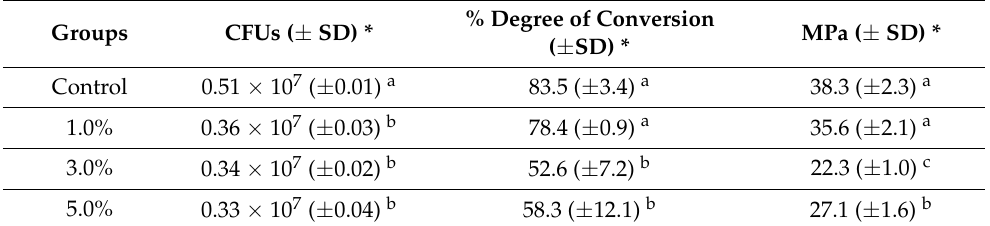
Table 2. Mean values and standard deviations of recovered S. mutans (in CFUs), % degree of conversion and µ TBS values (in